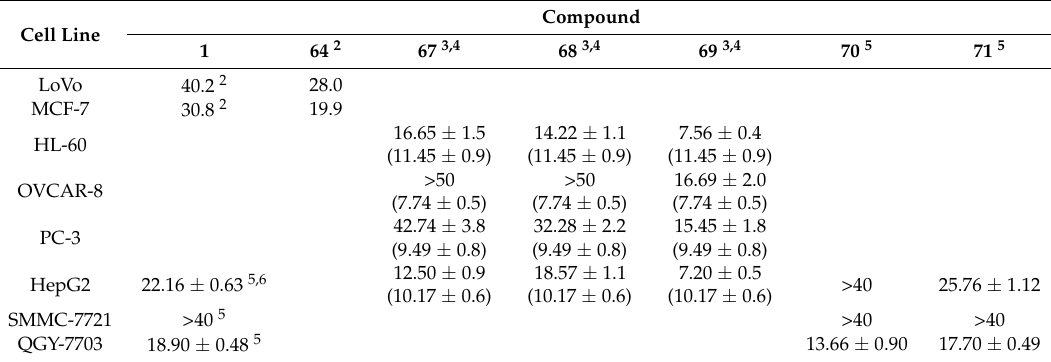
Table 13. Activity data for compounds 64 and 67 – 71 compared to quercetin 1